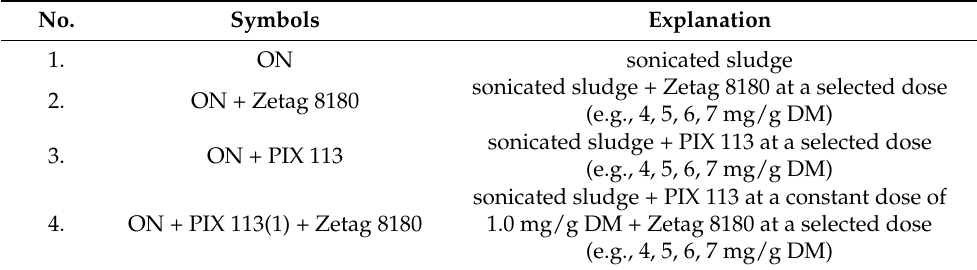
Table 3. Symbols assigned to tests carried out during the